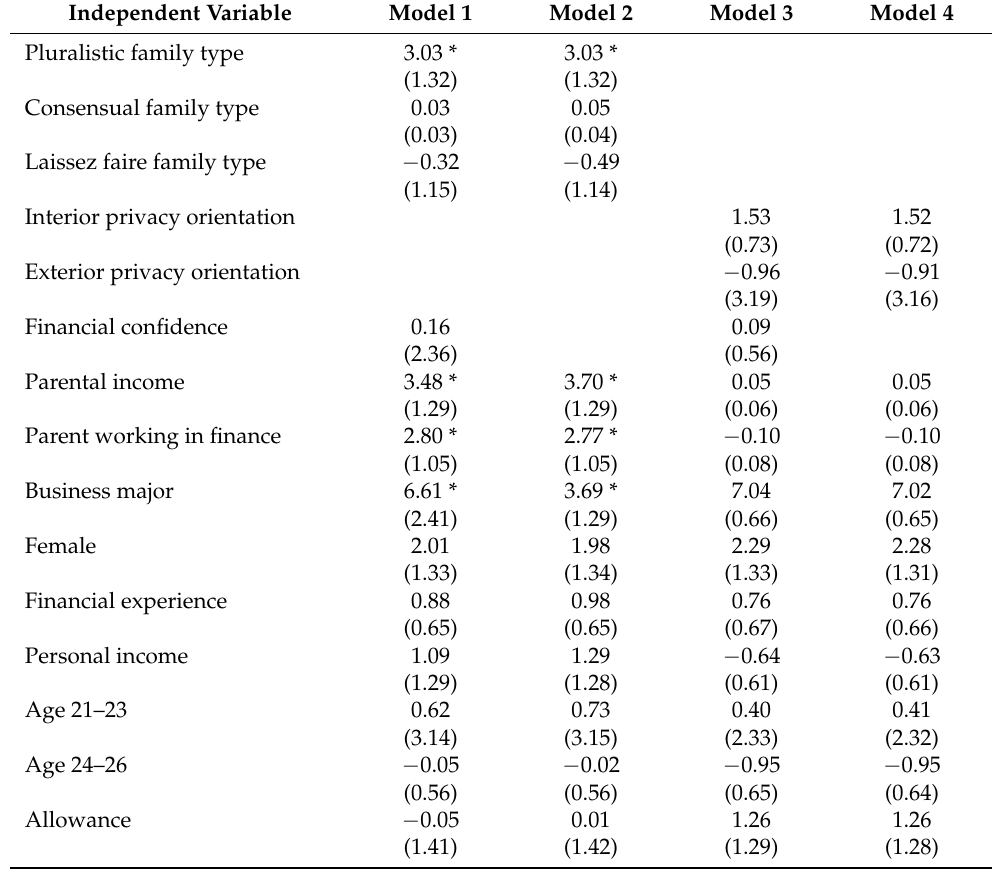
Table 5. Regression